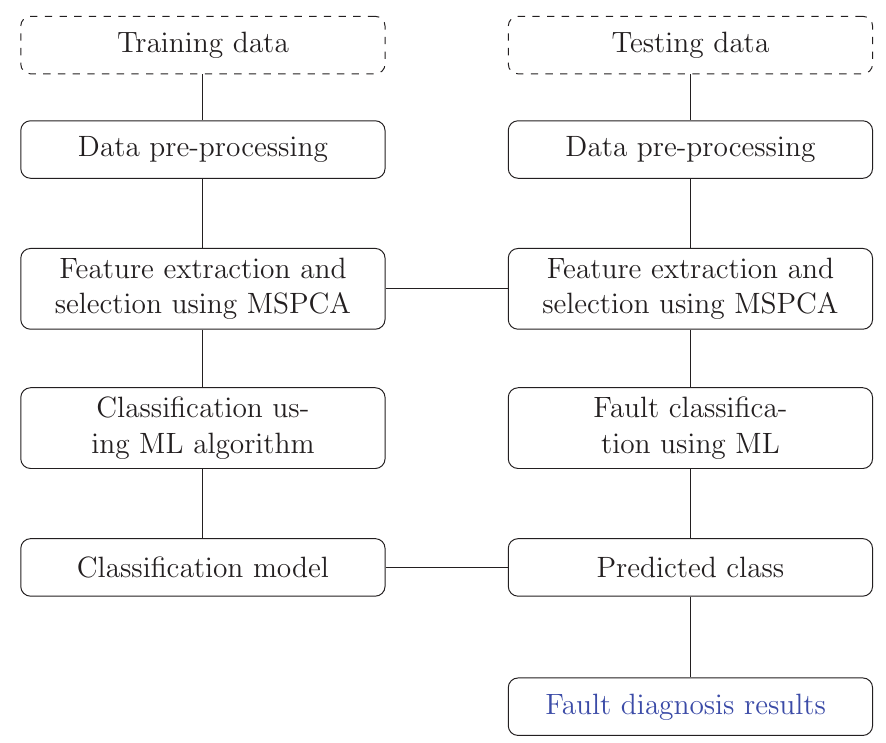
Figure 1. Illustration of MSPCA-based ML procedure for fault detection and